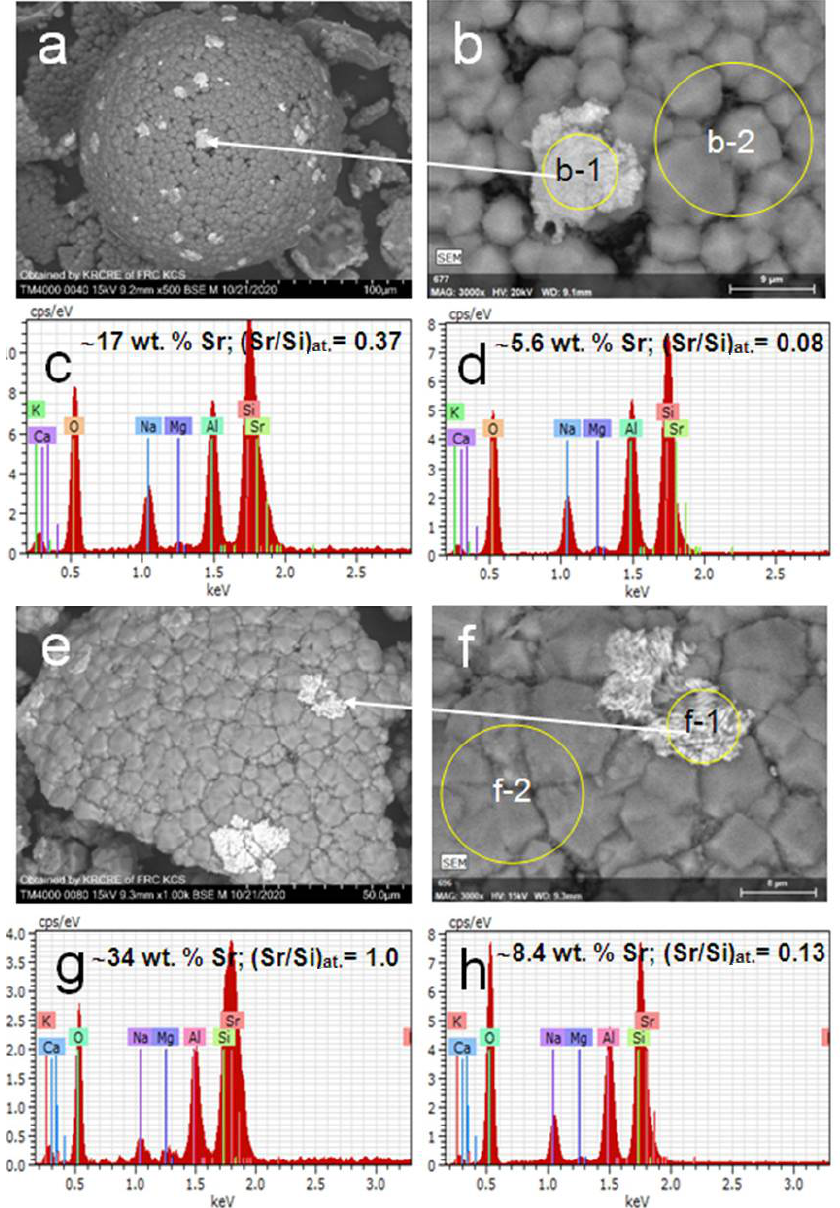
Figure 5. SEM images of product particles resulted from hydrothermal treatment of the Sr(NO 3 ) 2 - H 2 O-ANA systems at ( a ) 25 ◦ C and ( e ) 200 ◦ C; ( b , f ) BSE micrographs and associated EDX spectra for local parts of the particles: ( c , d )—for points b-1 and b-2, accordingly; ( g , h )—for points f-1 and f-2, accordingly.